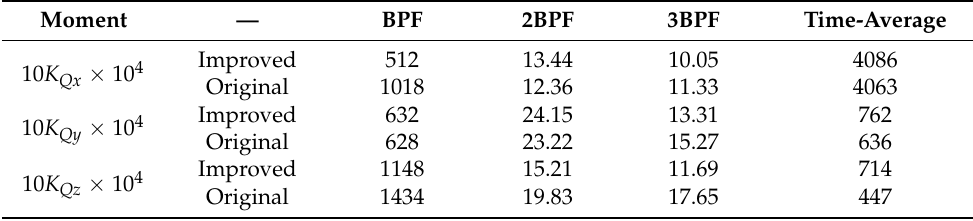
Table 6. The fluctuation peak of propeller torque and